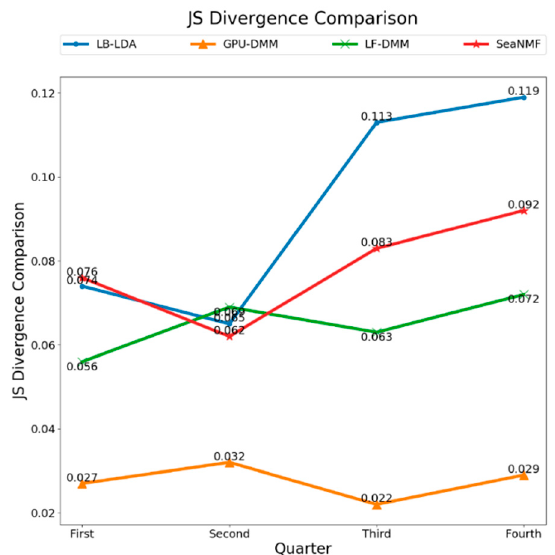
Figure 11. The JS divergence comparison among different topic models.